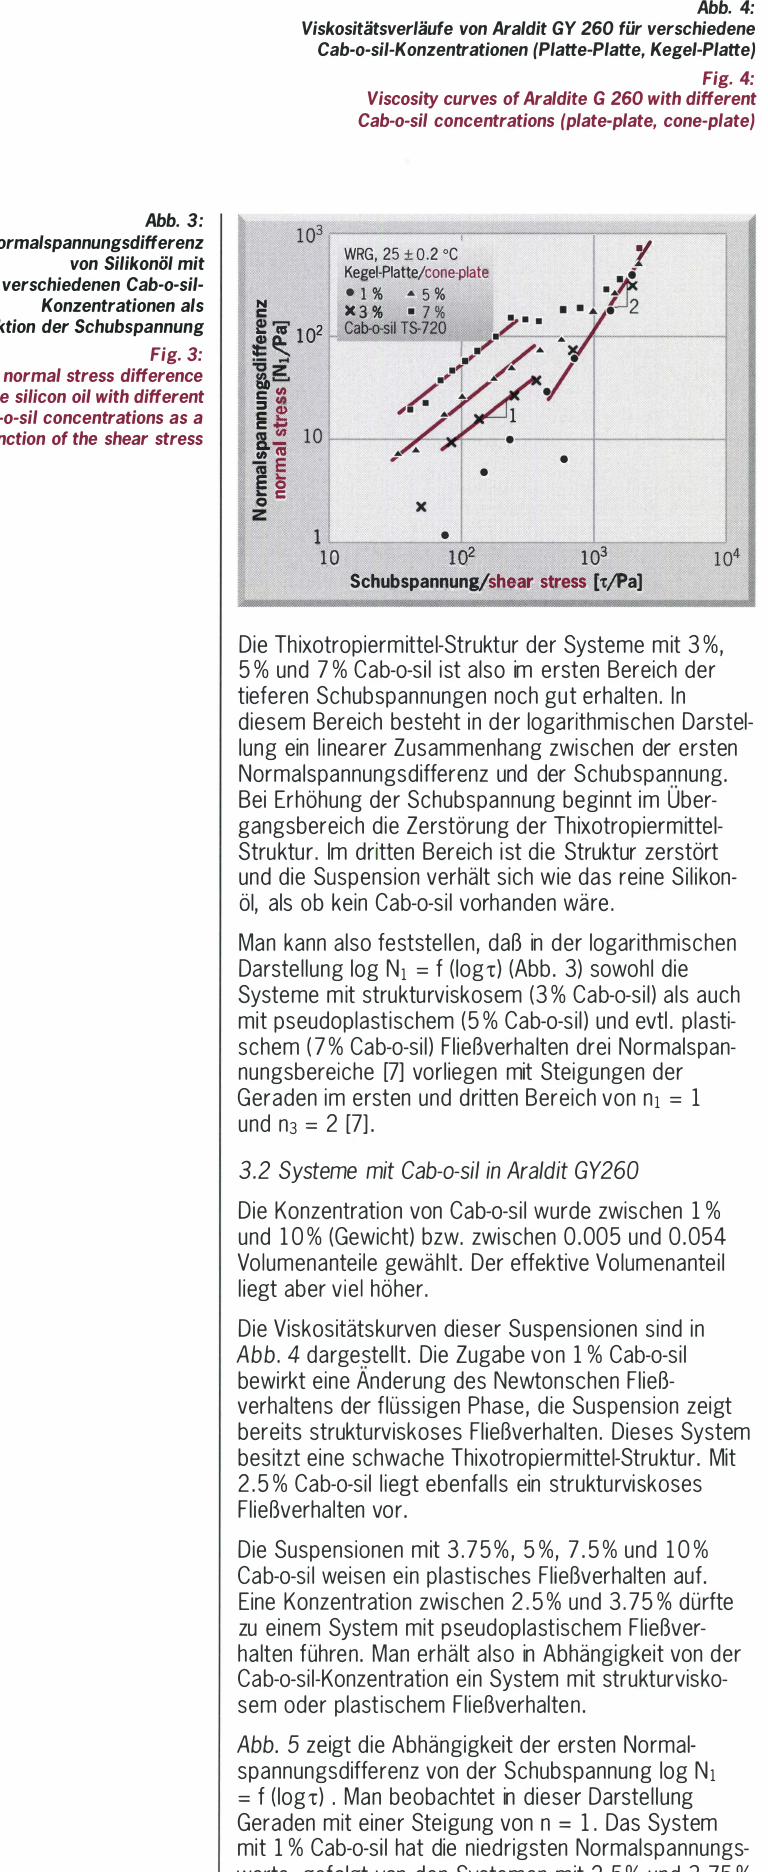
Fig. 4: Viscosity curves of Araldite G 260 with different Cab-o-sil concentrations (plate-plate,